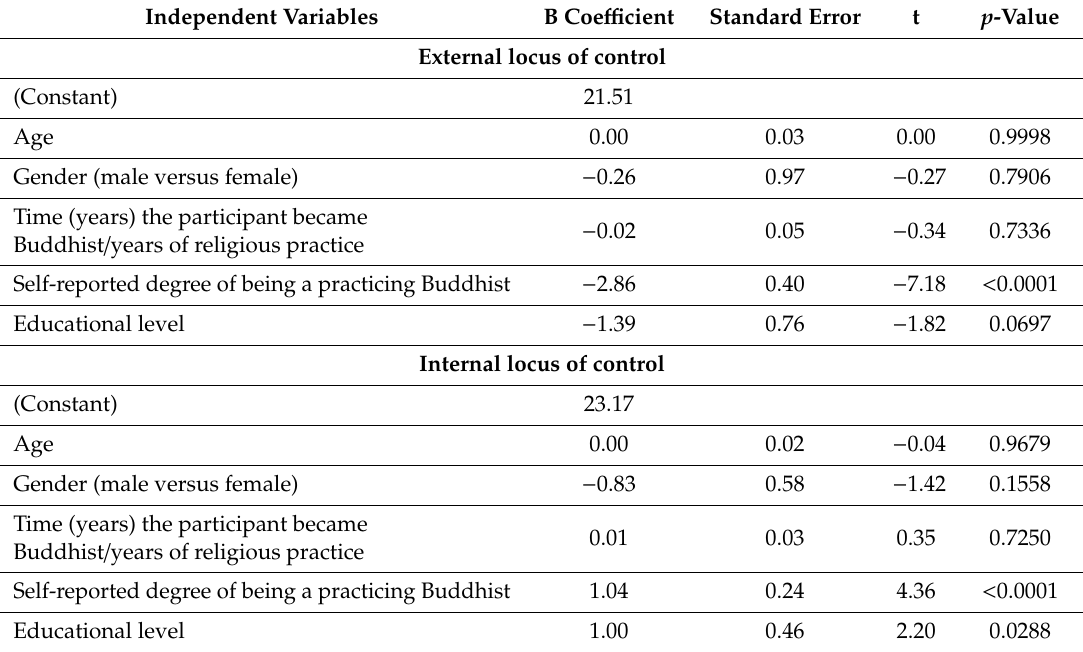
Table 3. Multiple regression analysis assessing determinants of external and internal locus of control in Italian Buddhists. Independent Variables B Coe ffi cient Standard